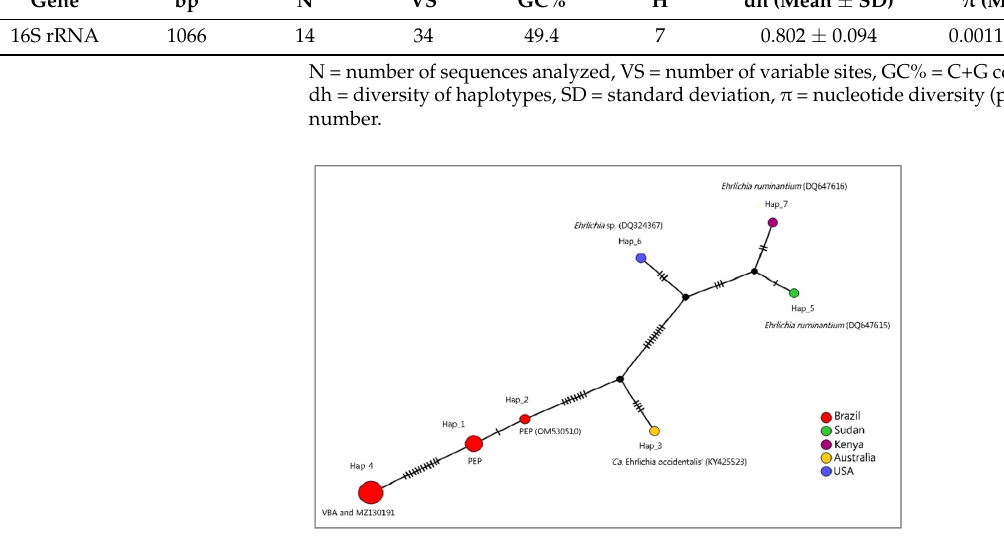
Figure 7. Median joining network containing Ehrlichia 16S rRNA sequences representatives of the two clades where sequences detected in coatis were positioned in the Bayesian Inference. While the lines between haplotypes represent mutational steps, the black circles indicate median vectors.